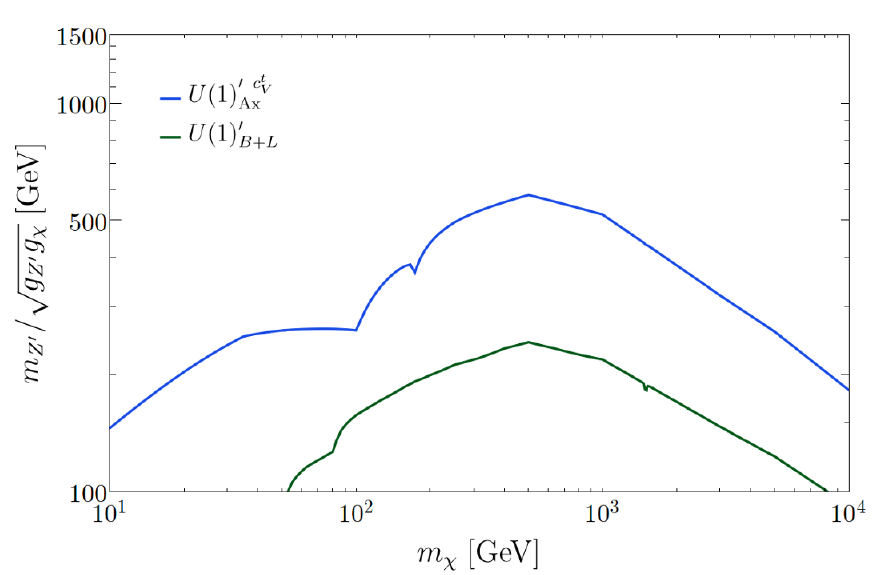
Figure 7 . Bounds due to IceCube [62] searches for neutrinos originating from DM annihilations